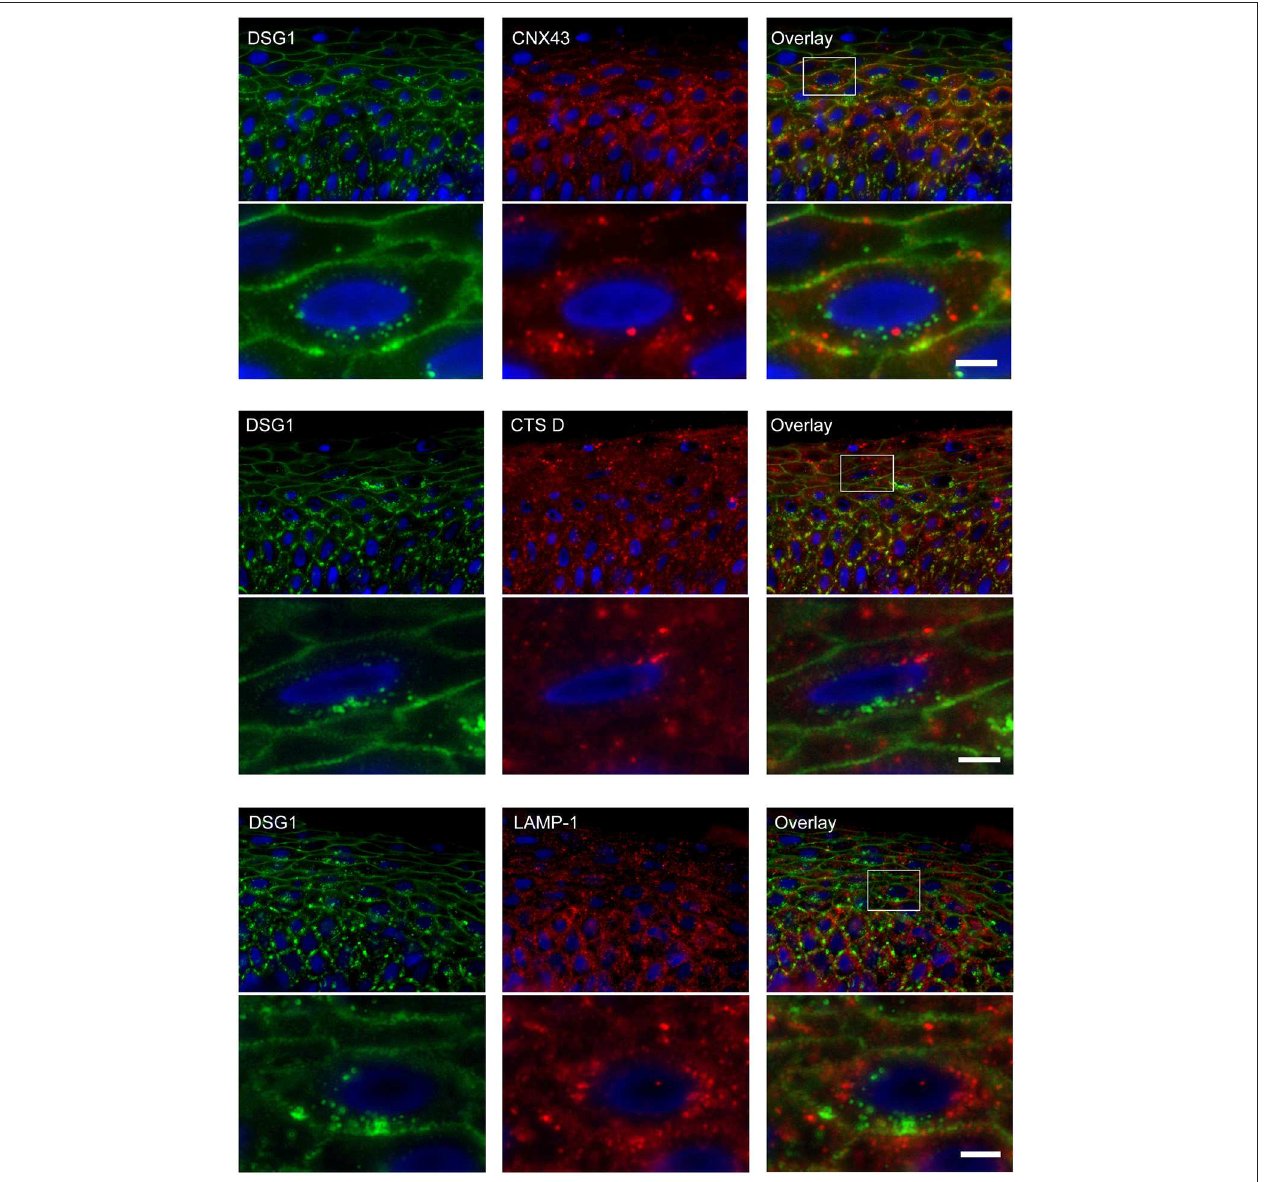
FIGURE 10 | No colocalization of endocytosed desmoglein 1 with connexin 43 and lysosomes in PF skin. Lesional PF patient skin stained for DSG1 and CNX43, upper panel overview with detail underneath, DSG1 and CTS D, middle panel overview with detail underneath, and DSG1 and LAMP-1, lower panel overview with detail underneath. The location of the detailed area is indicated by a white box in the overview. No colocalization is observed. White bar: 5 µ